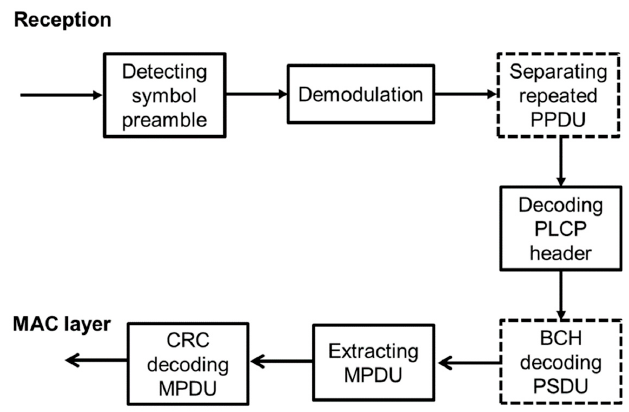
Figure 7. Block diagram of PHY receiver.